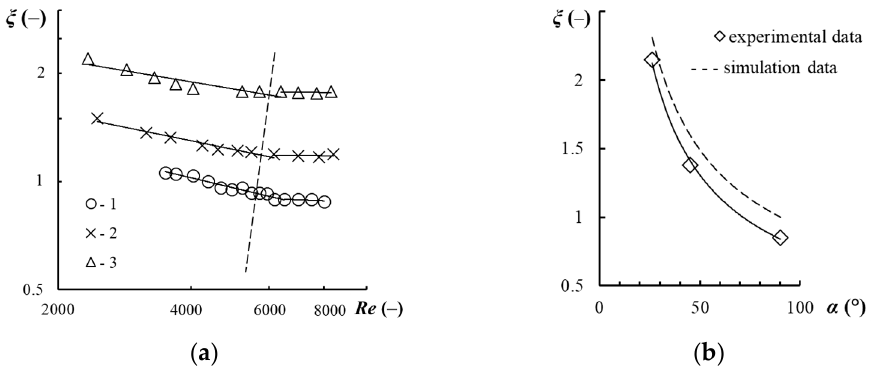
Figure 7. Dependence of the resistance coefficient on the Reynolds number with straight channels ( a ) and slope angle α ( b ): Experimental points at channel width b = 0.003 (m) and channel length l w = 0.004 (m) by different channel wall slope angle α .